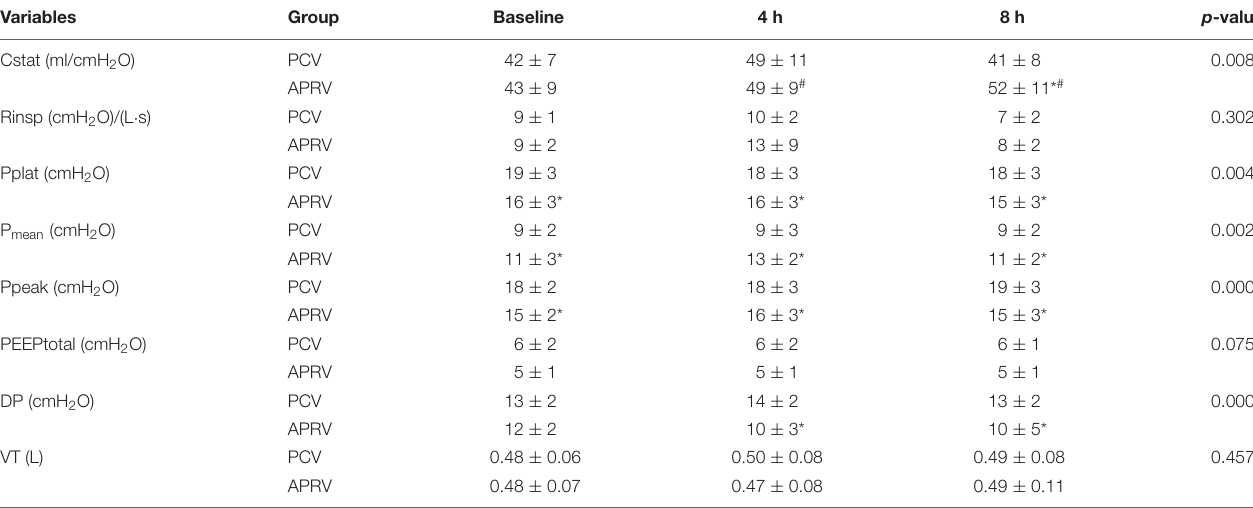
TABLE 3 | Ventilator settings after randomization after 4 h and respiratory mechanics after 1 and 4 h.